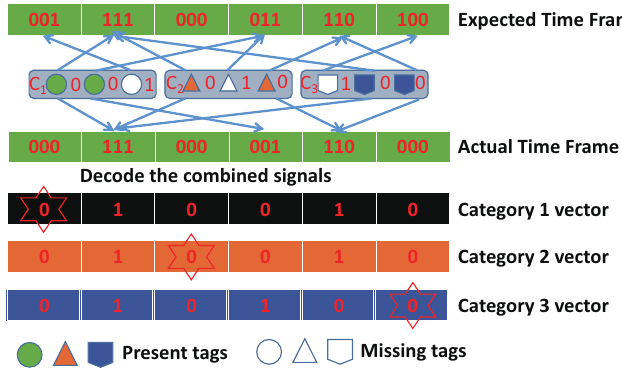
Figure 2. The decoding of received combined